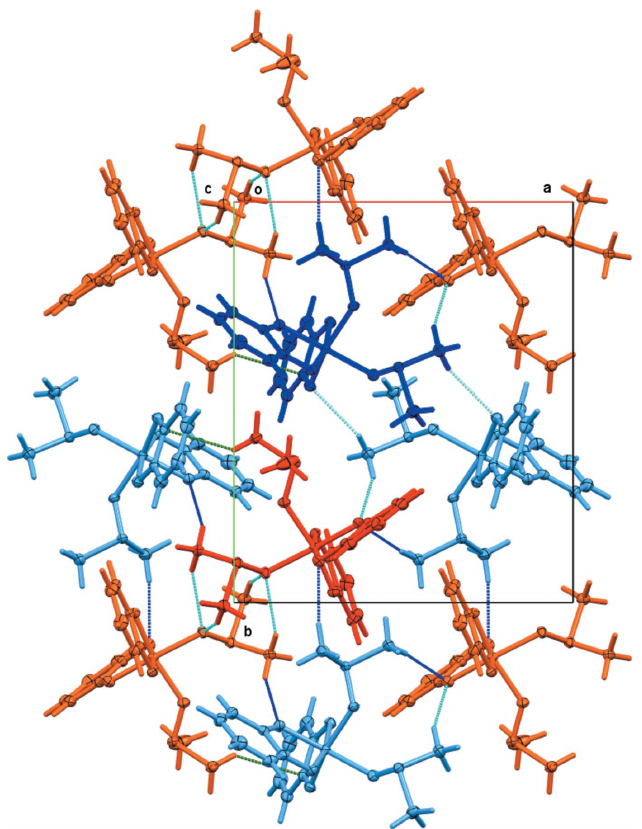
Figure 7 Directional interactions in 3 , viewed down the c axis. Red: molecule A , blue: molecule B . Lighter colored molecules are generated by crystal symmetry. Dark-blue dashed lines: C—H (cid:6)(cid:6)(cid:6) O bonds with H (cid:6)(cid:6)(cid:6) O distance < 2.5 A˚ ; light-blue dashed lines: C—H (cid:6)(cid:6)(cid:6) O bonds with H (cid:6)(cid:6)(cid:6) O distance between 2.5 and 2.62 A; green dashed lines C—H (cid:6)(cid:6)(cid:6) (cid:5) contacts. 50% probability